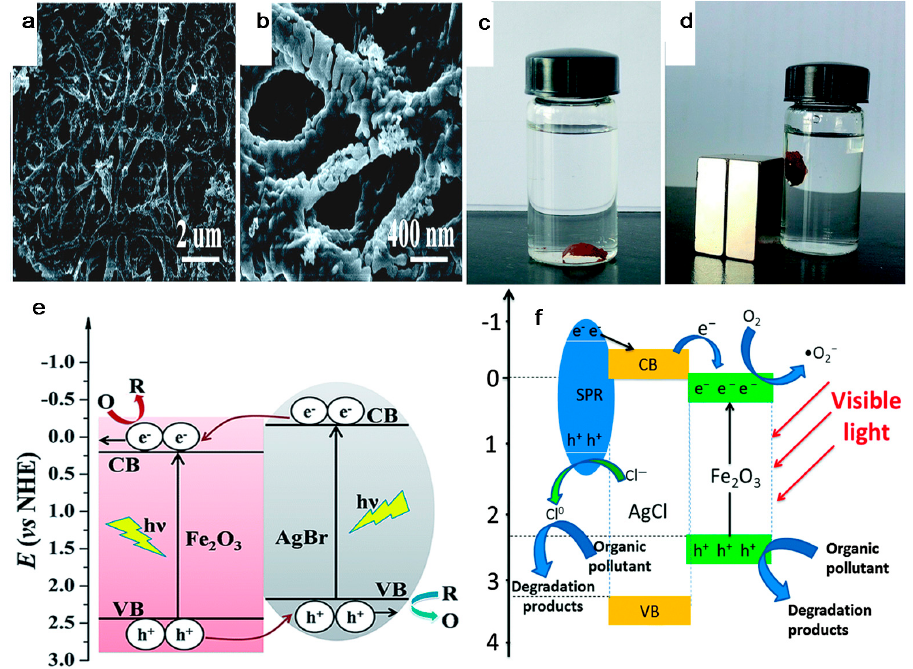
Figure 1. ( a , b ) SEM images of α -Fe 2 O 3 -AgBr nonwoven cloth; ( c , d ) illustration of magnetic separation of α -Fe 2 O 3 -AgBr cloth and charge transfer mechanism in ( e ) α -Fe 2 O 3 -AgBr cloth (Reproduced with permission from [81], Copyright 2015, RSC); and ( f ) Ag/AgCl/Fe 2 O 3 . Reproduced with permission from [39]. Copyright 2016, RSC.